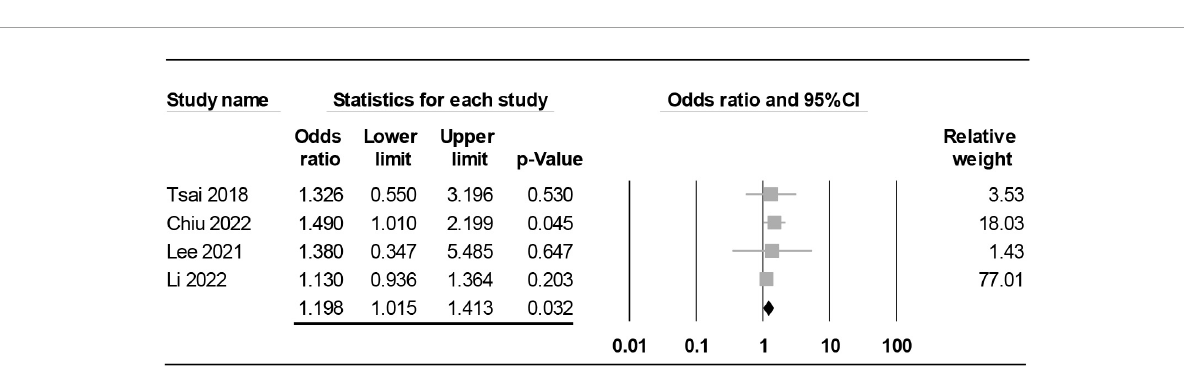
FIGURE8 Forest plot demonstrating association of maternal rheumatoid arthritis with risk of offspring autism spectrum disorder in studies from Asian countries. CI, confidence